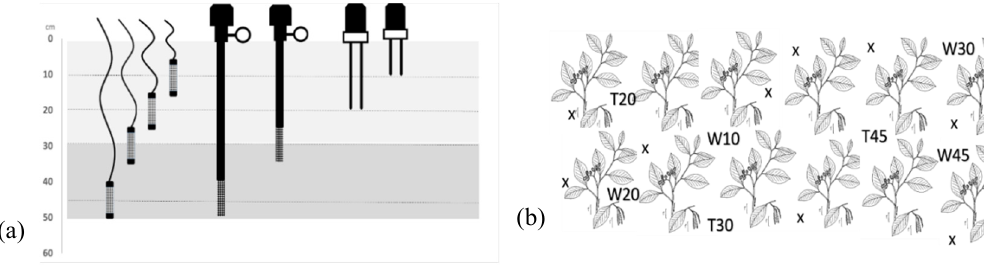
Figure 4. The position of tested sensors regarding the monitoring depth ( a ) and location in the experimental plot ( b ).